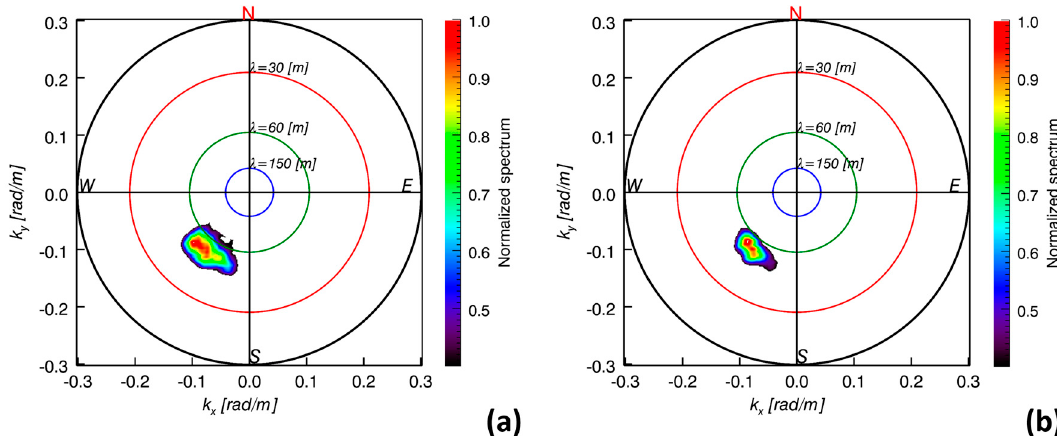
Figure 6. Directional spectra provided by the wave radar system during the measurement campaign on 15 May 2015. ( a ) directional spectrum at 12:40 UTC; ( b ) directional spectrum at 14:05 UTC.